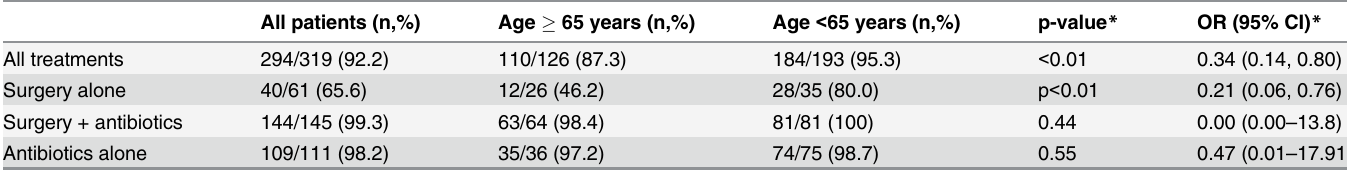
Table 5. Treatment success for first MU lesions. All patients